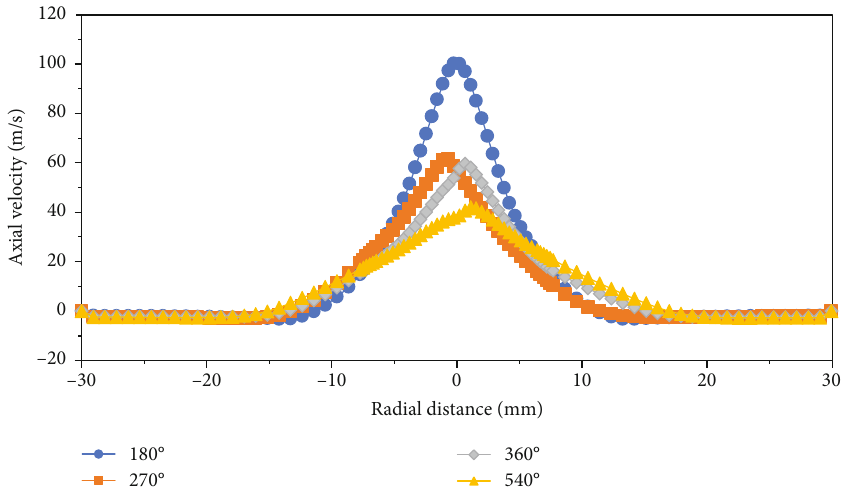
Figure 13: Axial velocity distribution of di ff erent spinning angles in h / d = 8 .